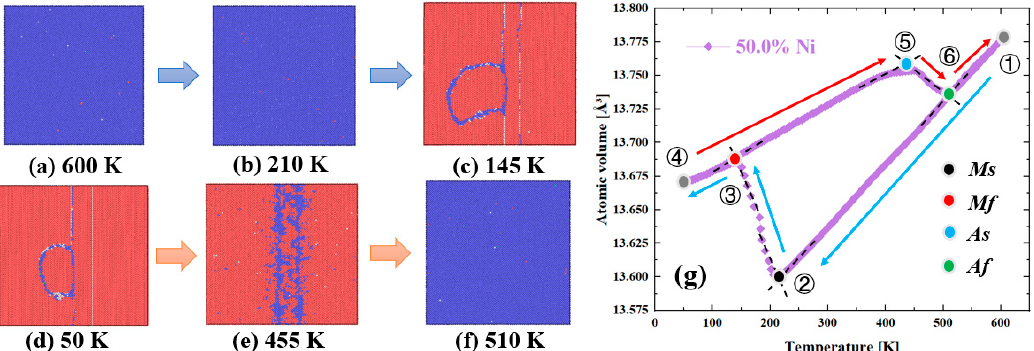
Figure 11. ( a – f ) Phase structure of equiatomic NiTi model during cooling and heating processes. The blue and red atoms represent austenite and martensite structures, respectively. ( g ) Evolution of atomic volume during cooling and heating processes, where ① – ⑥ correspond to ( a – f ).